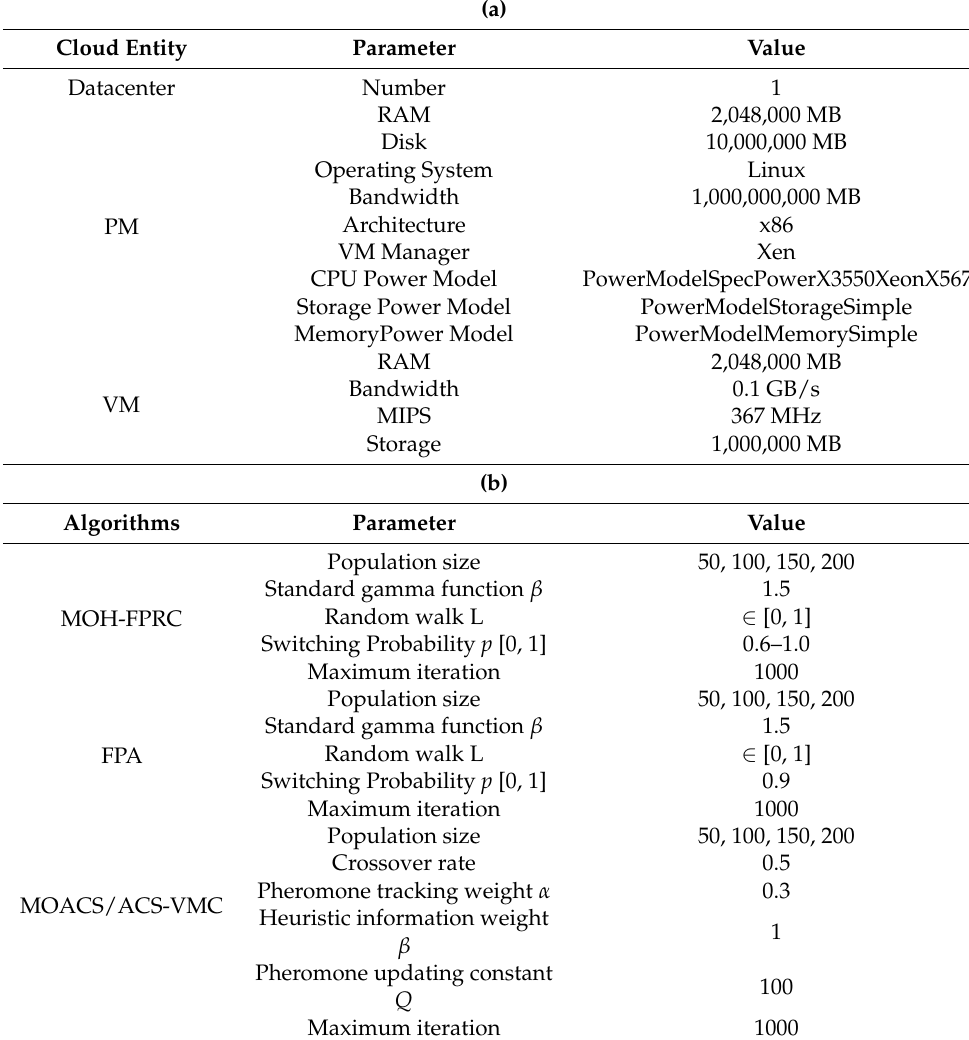
Table 1. Simulation settings: ( a ) PM and VM Parameters setting ( b ) Parameter settings of the compared